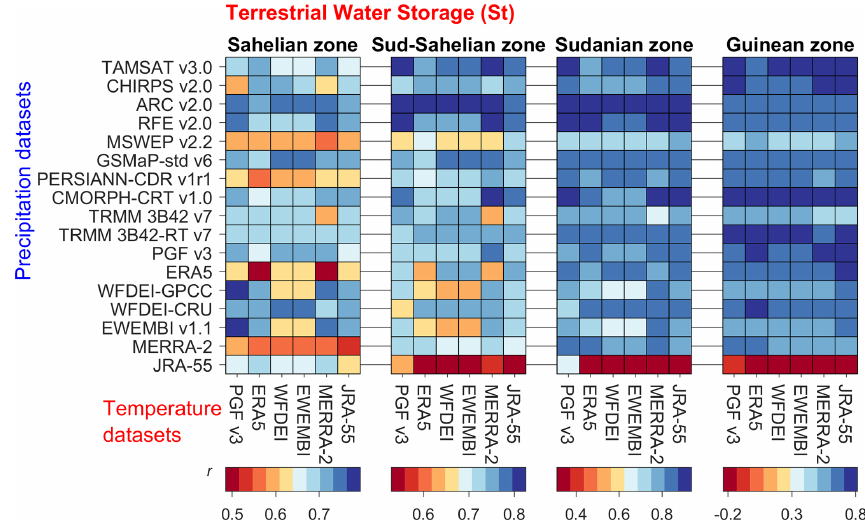
Figure 4. Pearson correlation coefficient ( r ) of modelled terrestrial water storage compared to GRACE data in four climatic zones in the Volta River basin over the simulation period (2003–2012) considering 102 combinations of rainfall ( y axis) and temperature datasets (subplots on the x axis) used as forcing for the hydrological